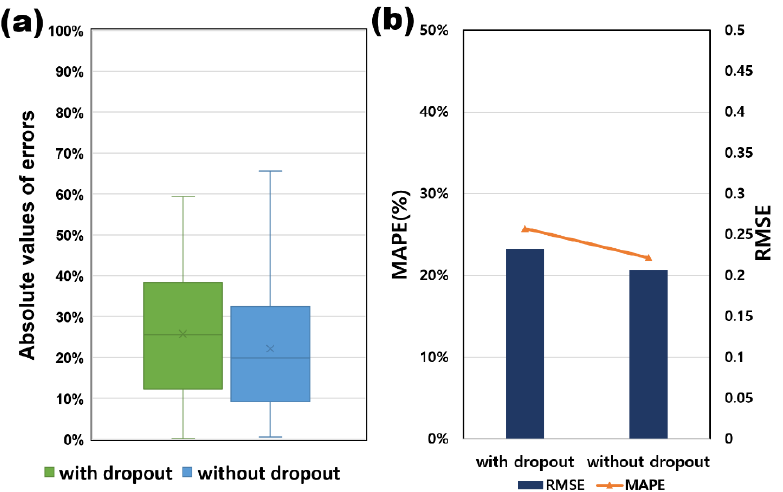
Figure 14. Dropout method sensitivity analysis results of DNN models. ( a ) absolute error ( b ) RMSE and MAPE.